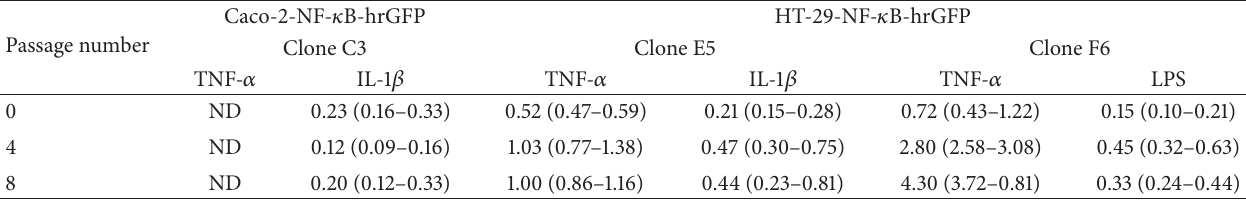
Table 2: NF- 𝜅 B activation stability with passage number for different clones.